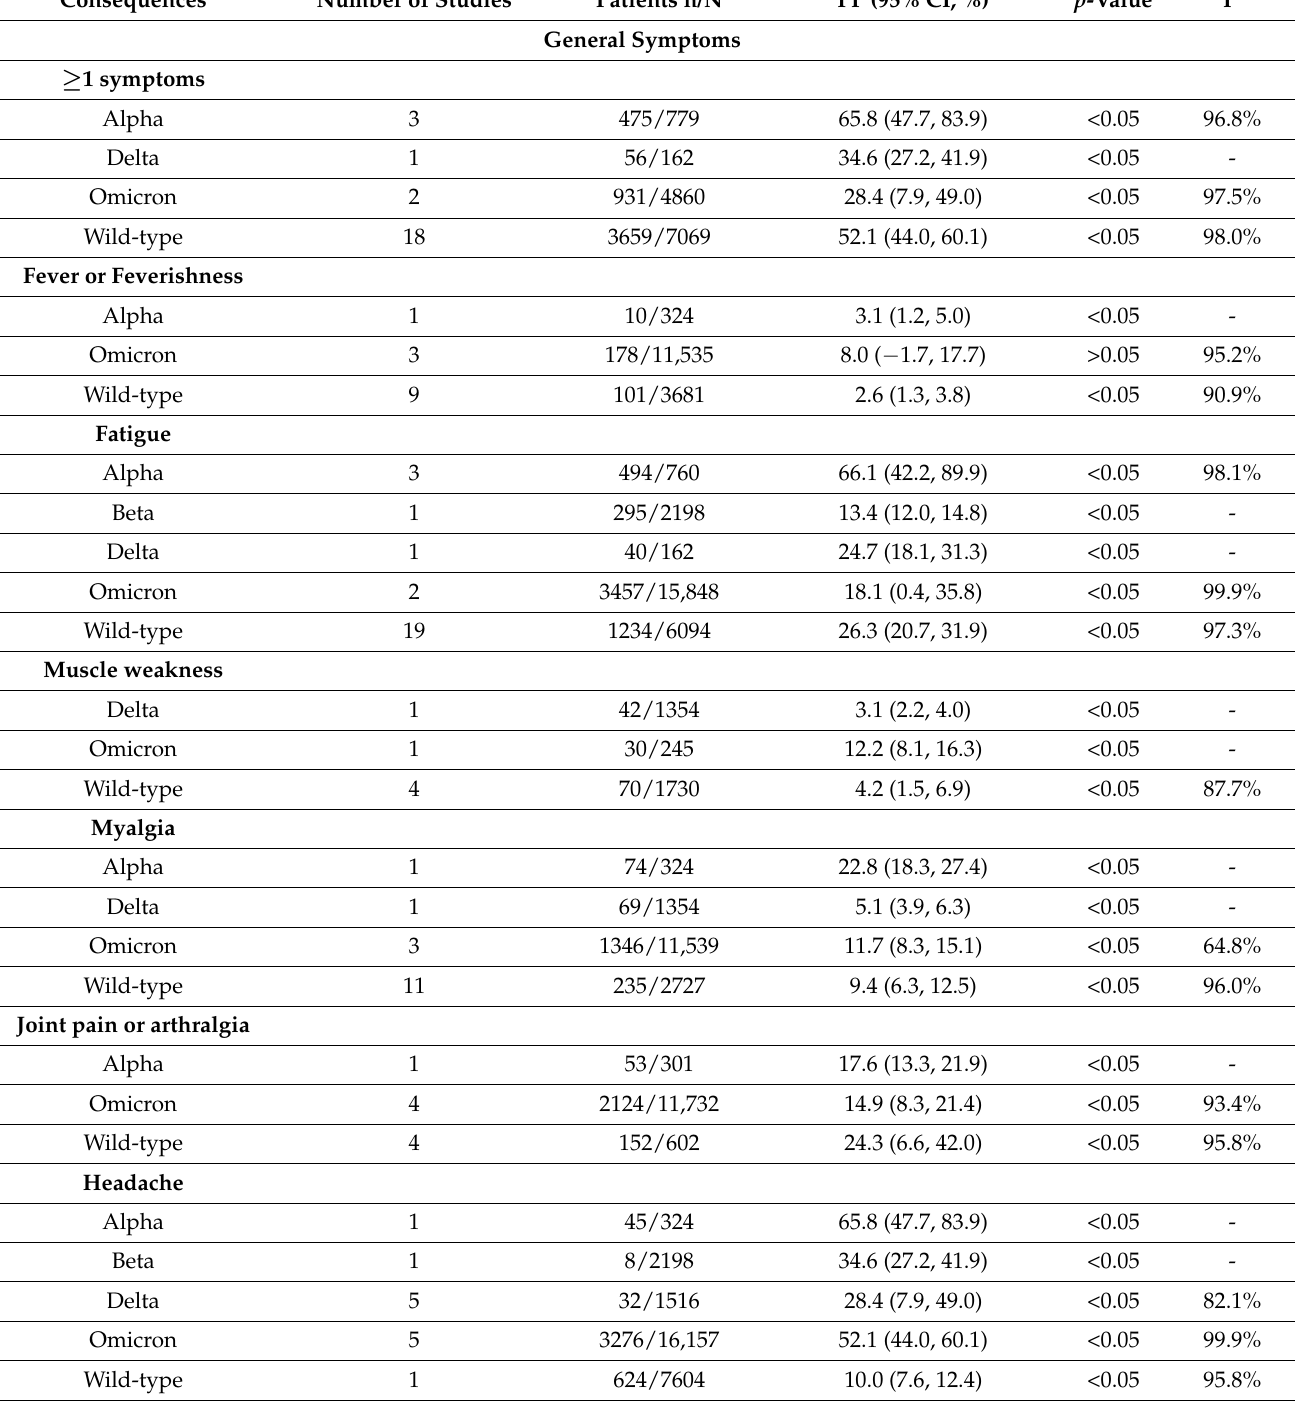
Table 1. Pooled prevalence of long COVID-19 by different strains at 3 months follow-up and